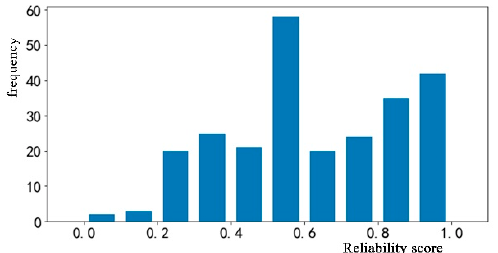
Figure 44. Histogram of the borehole data reliability index frequency.